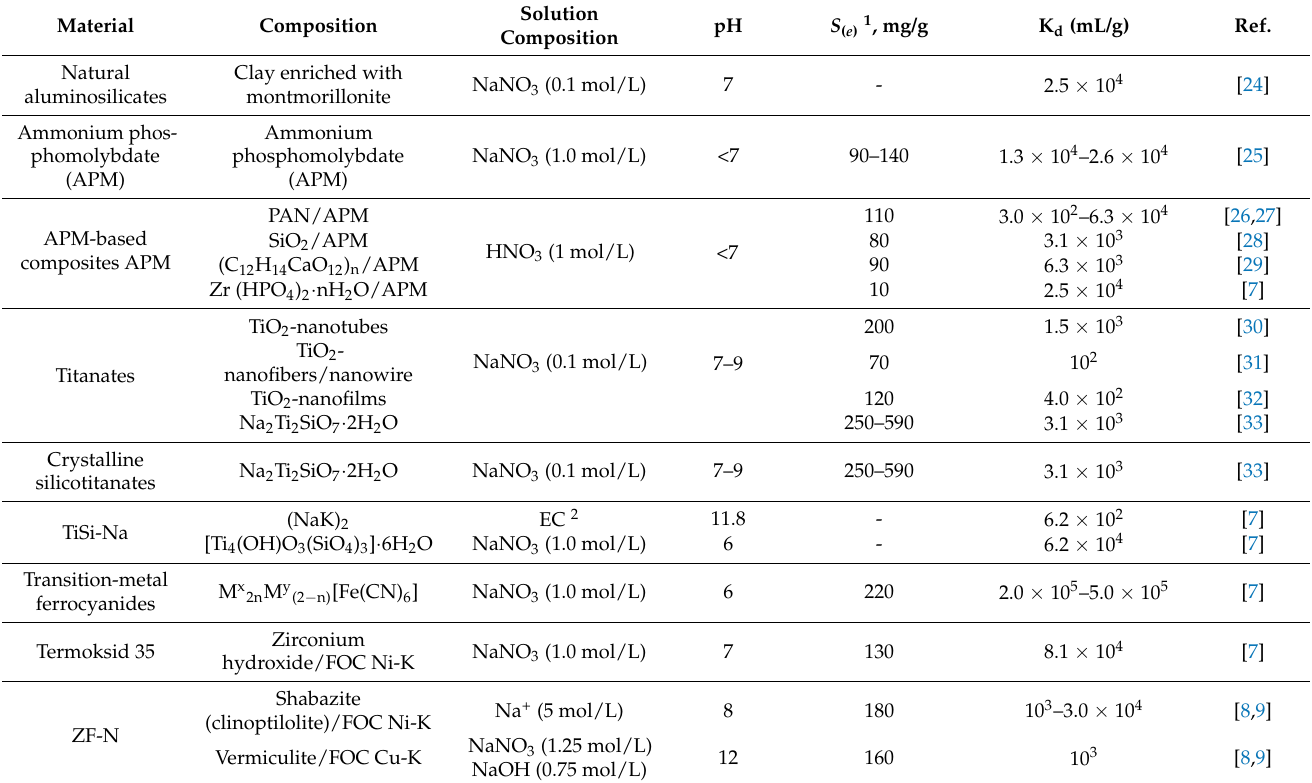
Table 1. Comparative characterizations of sorption materials from Cs removal from liquid